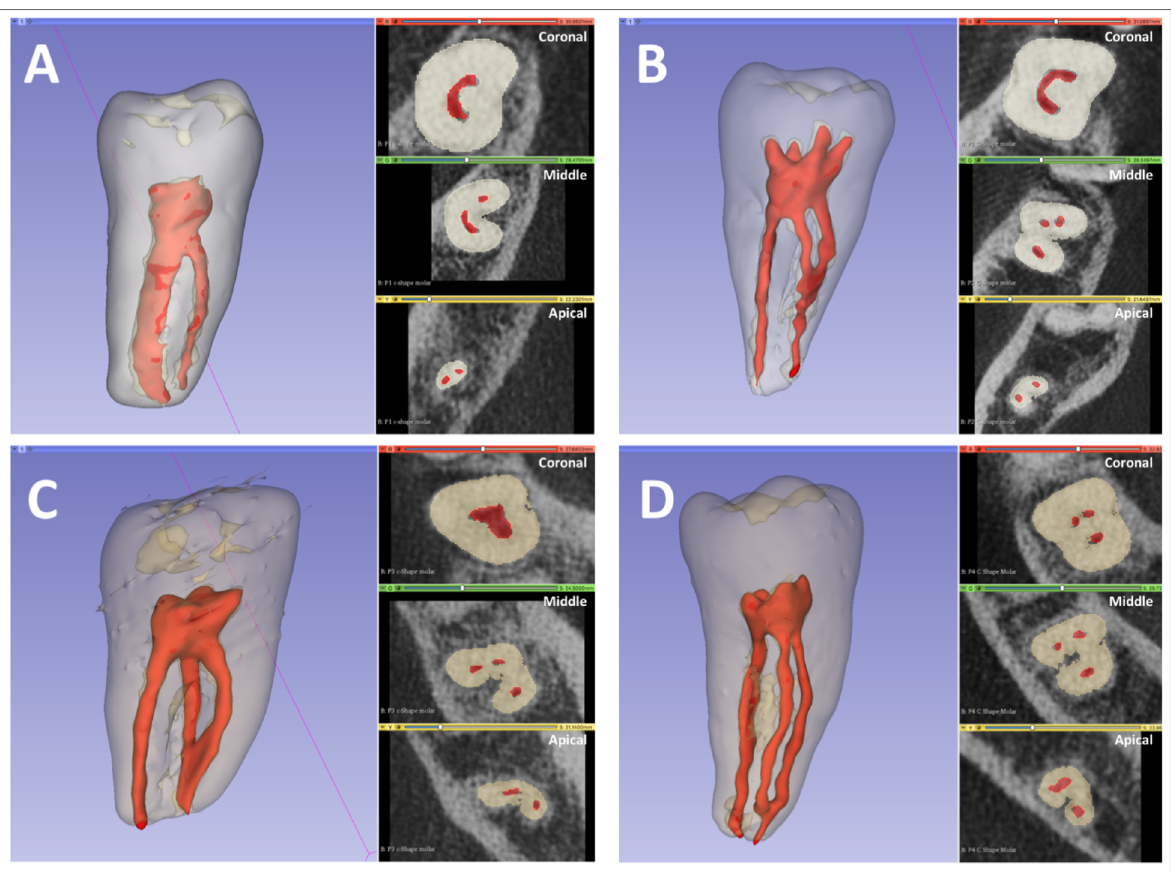
Figure 5:. 3D reconstruction of the most common types of morphological change in C-shape configuration along the root length; ( A ) T1: C1-C2-C3d, ( B ) T2: C1-C3c-C3d, ( C ) T3: C4-C3c-C3d and ( D ) T4: C3c-C3c-